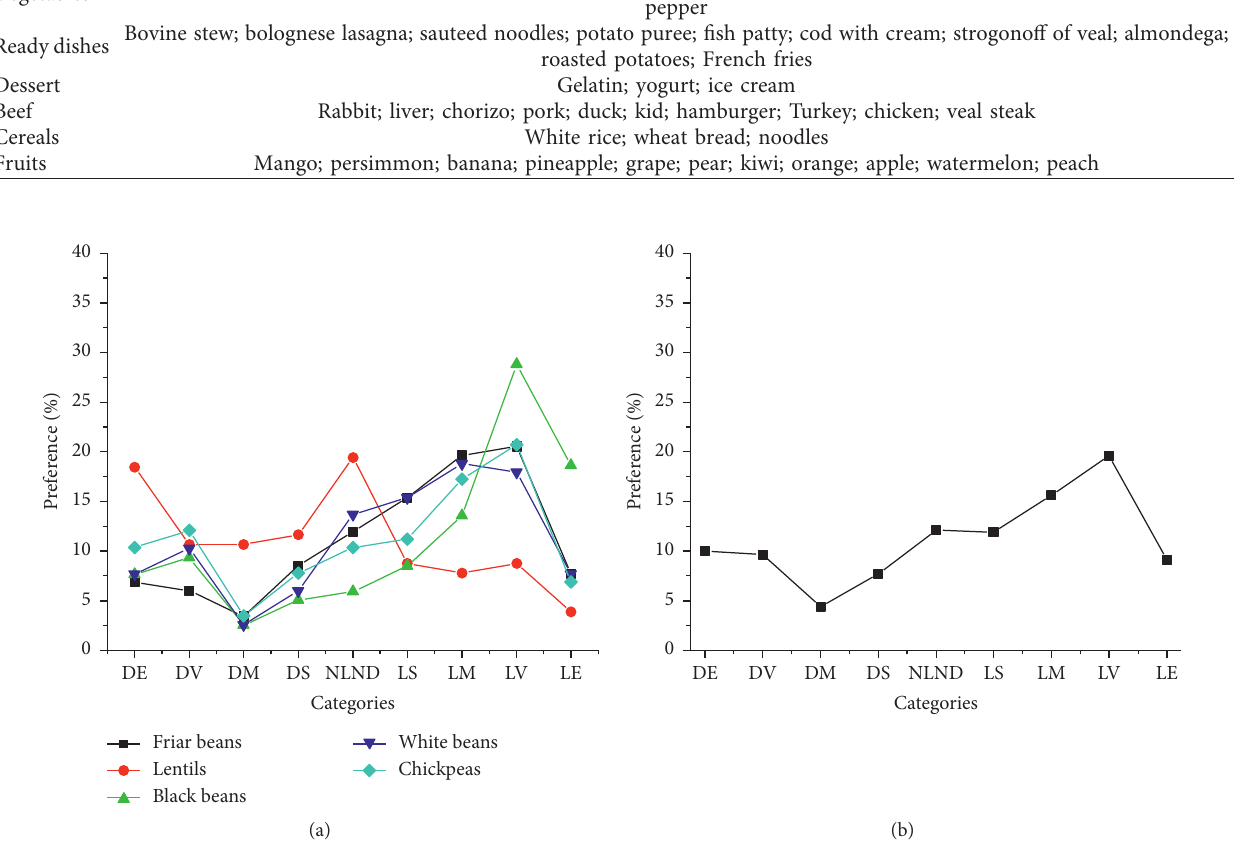
Figure 6: Food preference results. (a) Each legume group food. (b) Legume group as a